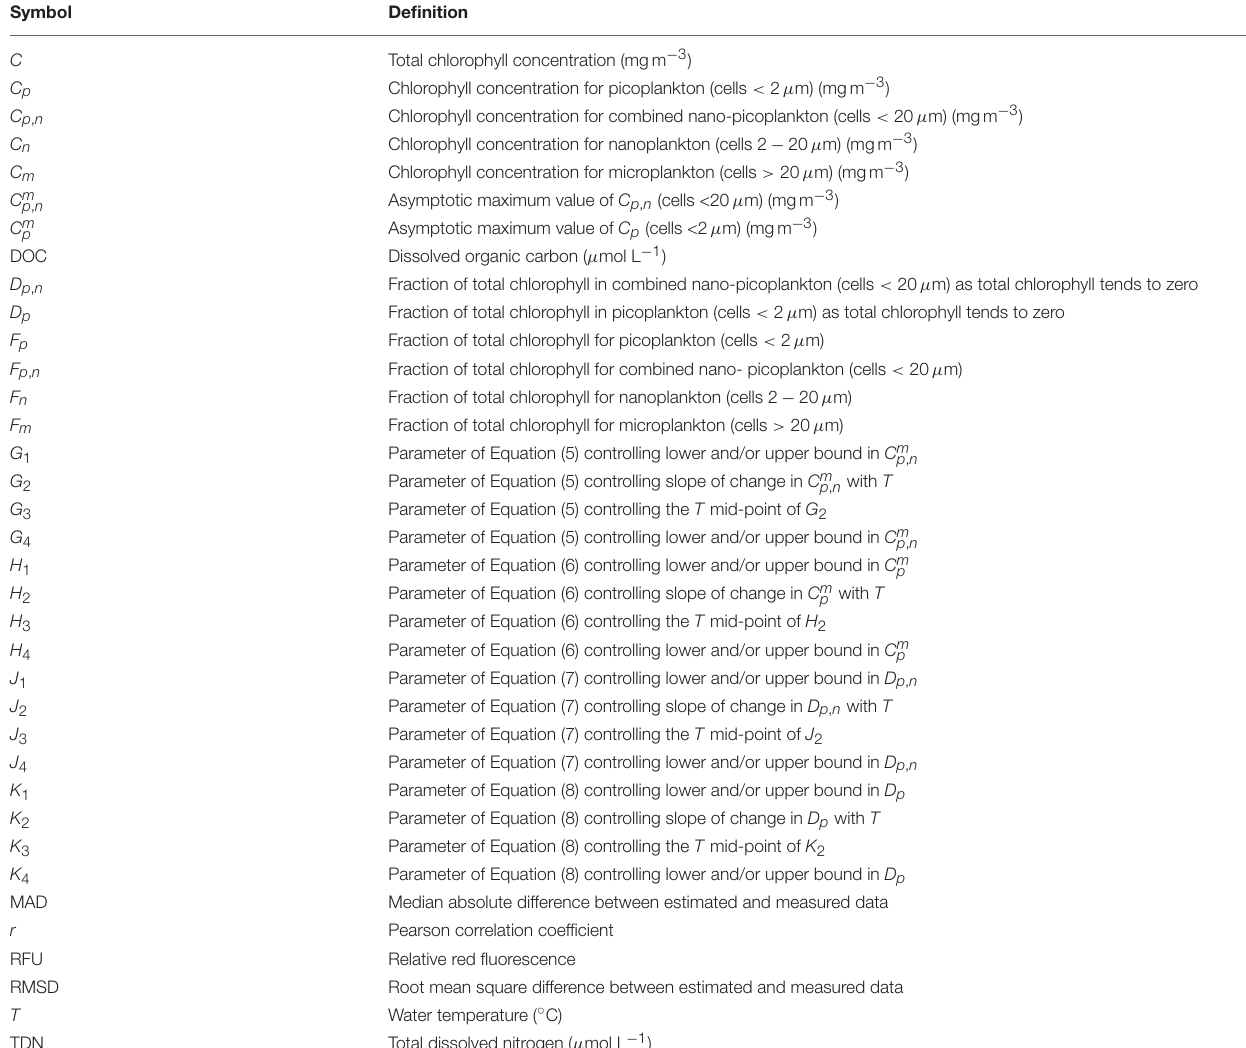
TABLE 1 | Symbols and definitions.